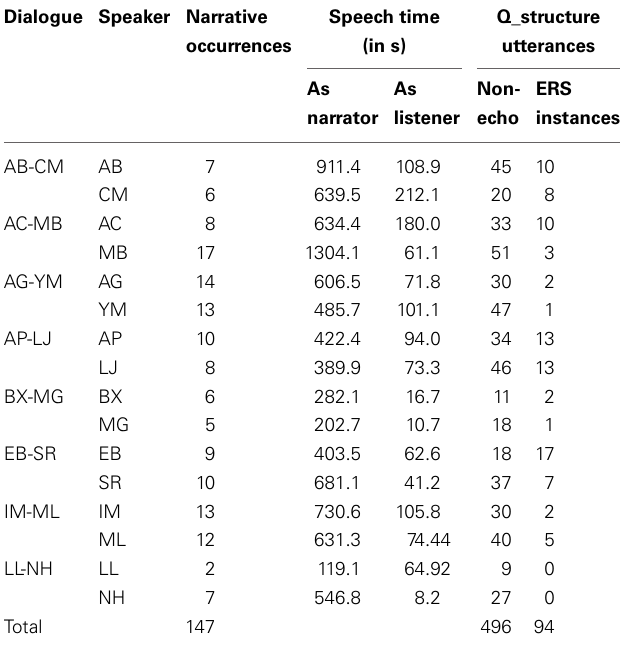
Table 1 | Descriptive data for each speaker: narratives, speech time, reported speech and ERS